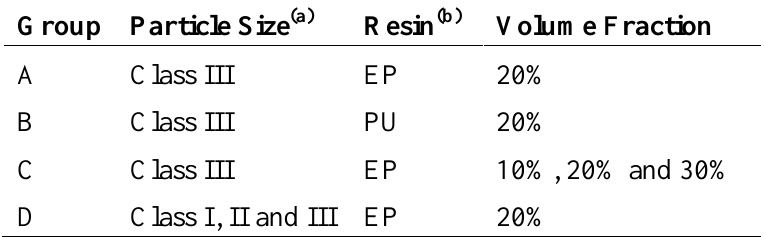
Table 2. Specimens for magnetic